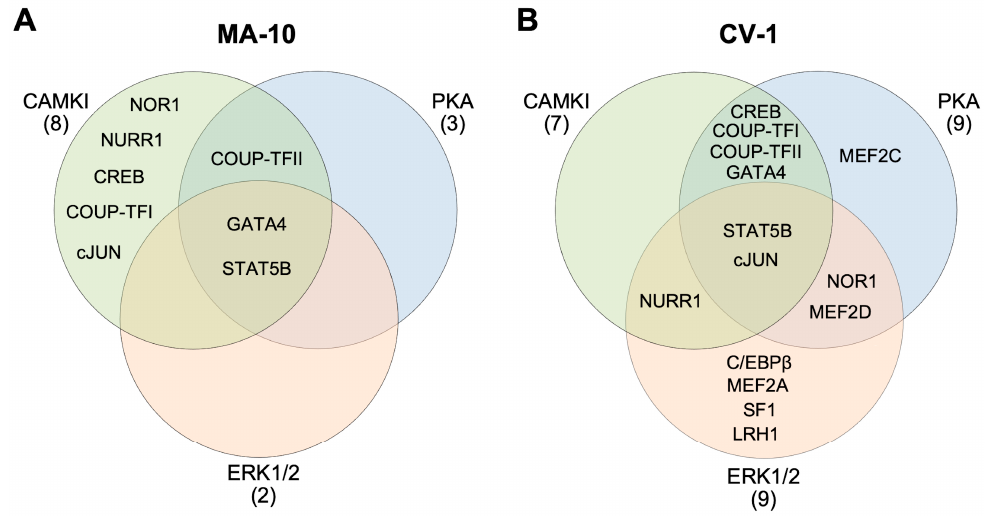
Figure 6. Cooperation of transcription factors and kinases on the Star promoter in steroidogenic (MA-10) vs. non-steroidogenic (CV-1) cells. The three-set Venn diagram highlights the transcription factors that cooperate with CAMKI CA (green circles), PKA C α (blue circles), and MEK1 CA (activating ERK1/2, orange circles) in MA-10 Leydig ( A ) and in CV-1 fibroblast ( B ) cells. Table 1. Transactivation potential of transcription factors by different kinases.